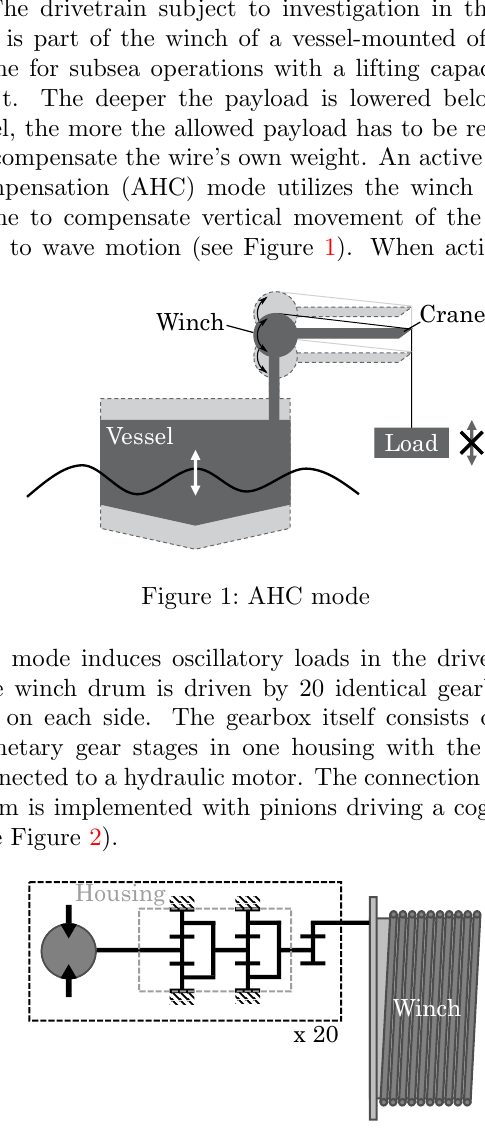
Figure 2: Structure of winch